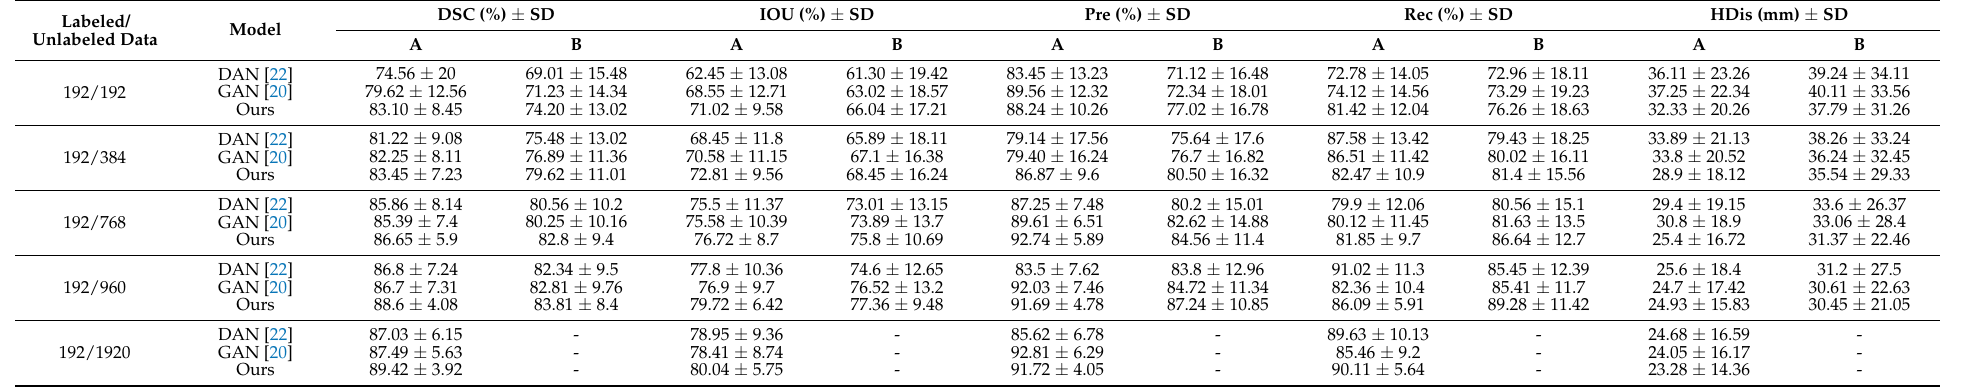
Table 3. Semi-supervised model performance results compared to GI dataset: Lab (A) data and EAD2019 challenge data (B). Labeled/ Unlabeled